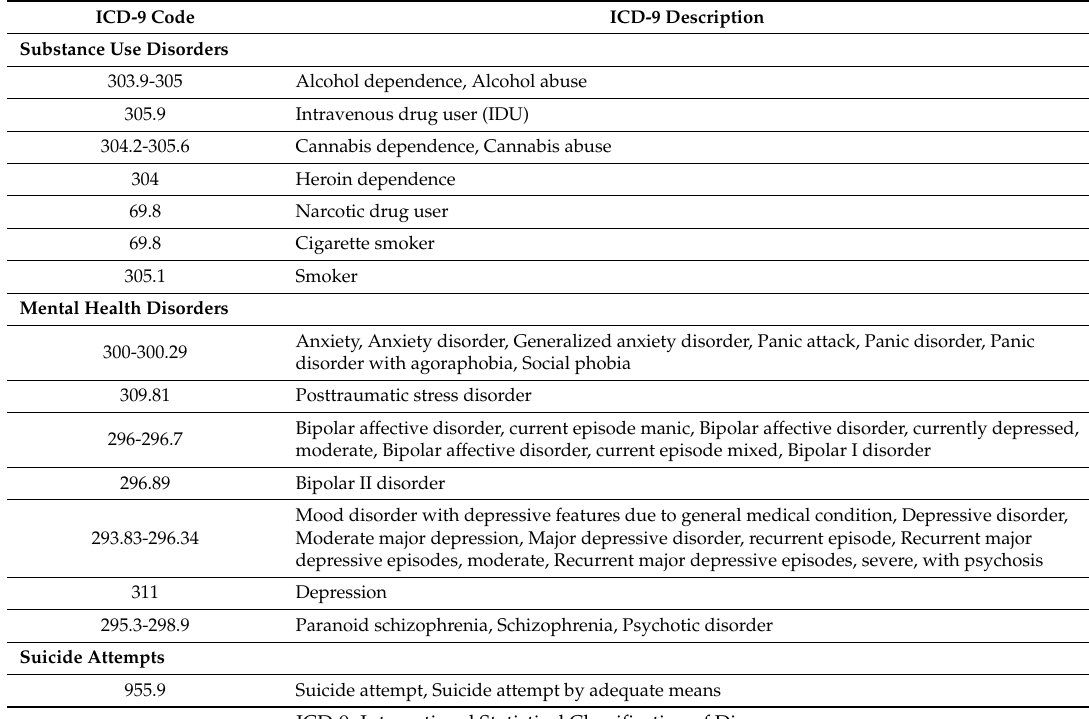
Table 1. Extracted substance use disorders, mental health disorders, and suicide